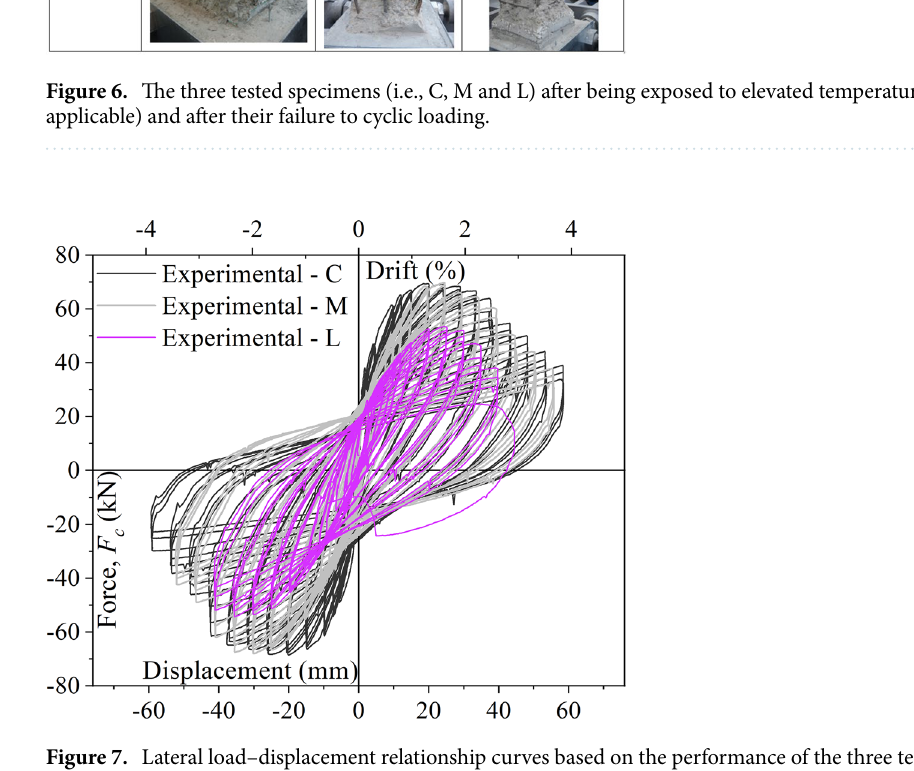
Figure 7. Lateral load–displacement relationship curves based on the performance of the three tested specimens (i.e., C, M and